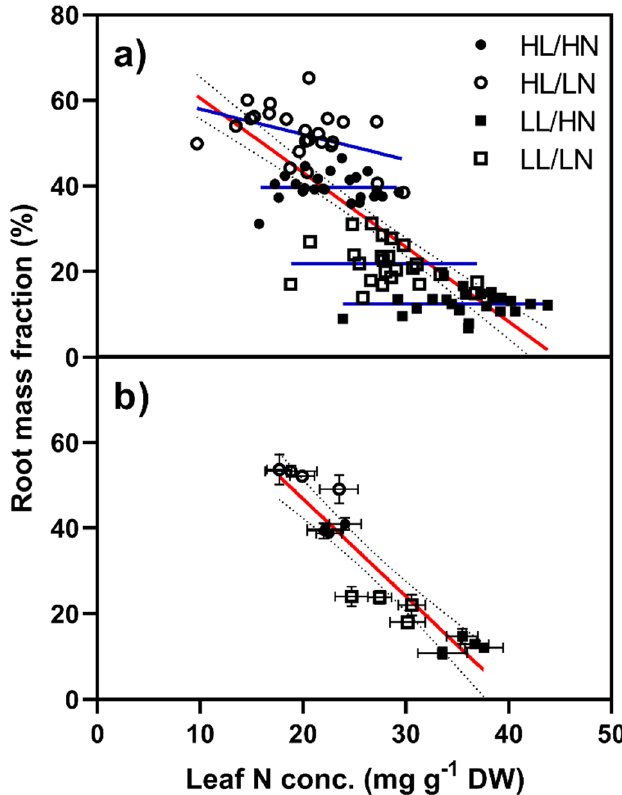
Figure 4. Root mass fraction plotted against leaf N concentration for Poa annua plants grown under high (HL) or low light (LL) conditions and supplied high (400 µg) or low N (100 µg). The red line represents a regression of RMF against leaf N concentration. In ( a ) each datapoint represents an individual plant and the blue lines represent regression lines for each treatment while in ( b ) each datapoint represents the mean of six replicates, with the error bars representing standard errors.